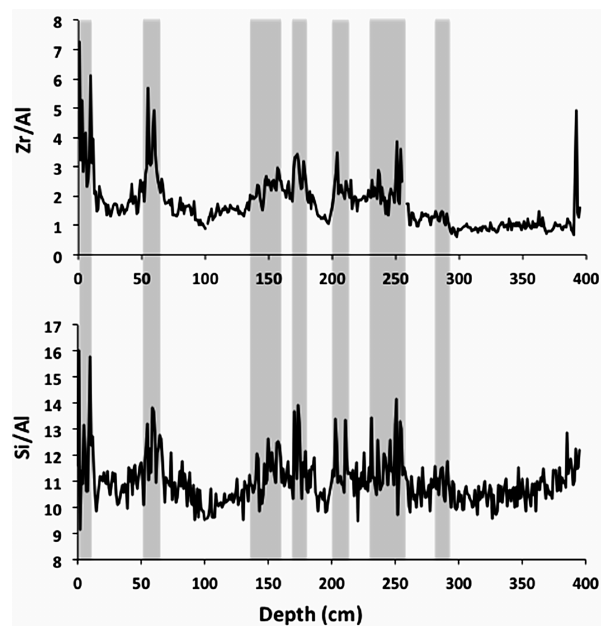
Figure 4. XRF records from the core MM2 with down-core varia- tions of the ratios Zr / Al and Si / Al. Shaded areas mark the main variations of Zr / Al and Si / Al.